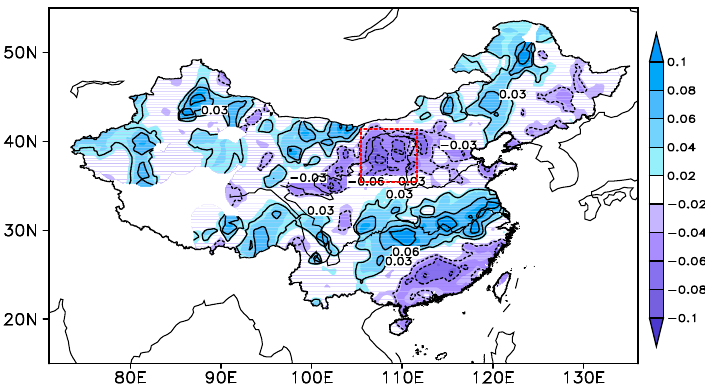
Figure 2. First EOF of the station-based summer extreme precipitation days in China, which explains 8.2% of the total variance. The red rectangle with the dashed line is defined as the YRLV region.